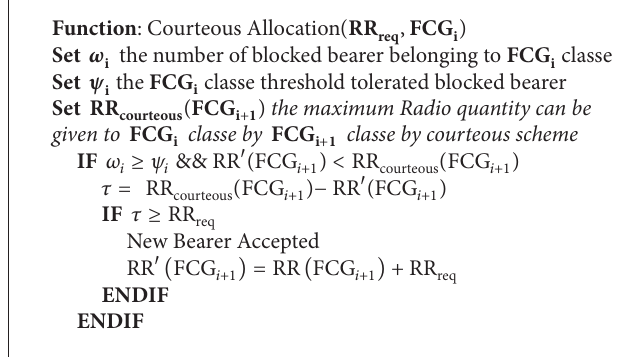
Algorithm 4: Courteous for frequencies function.